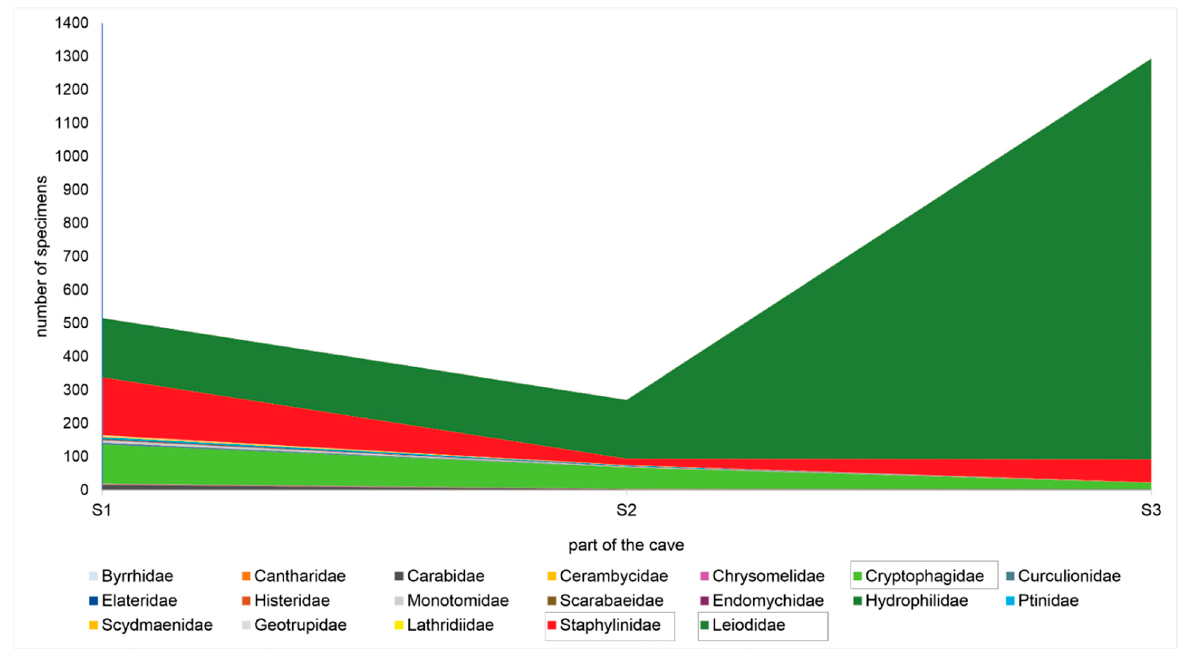
Figure 5. Distribution of beetles inside the caves; richness in particular parts of the caves is shown for all beetle families.